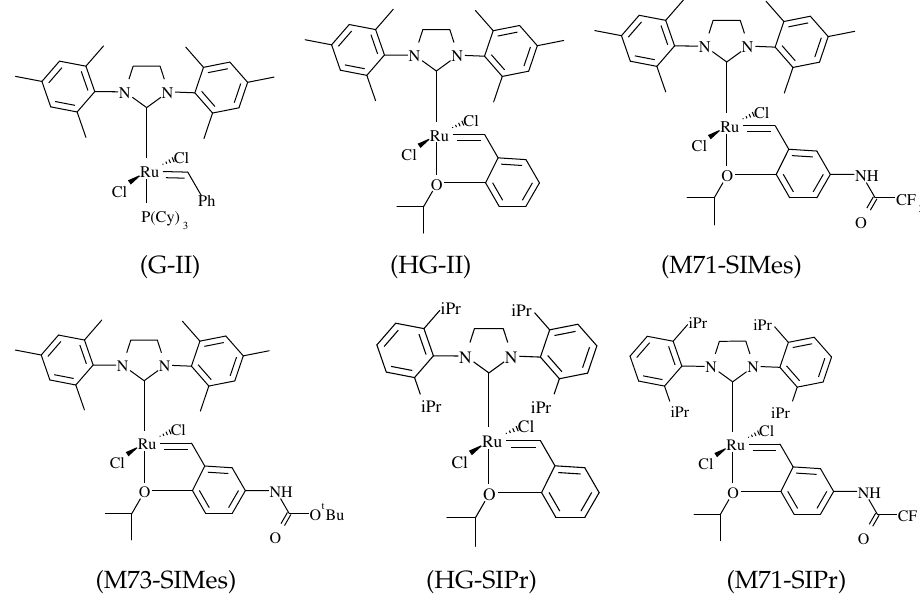
Figure 1. Ruthenium precatalysts.